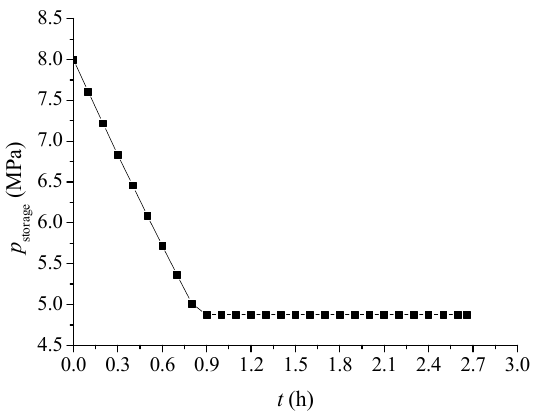
Figure 6. Variation of air pressure in the flexible bags with time during generation of electricity.